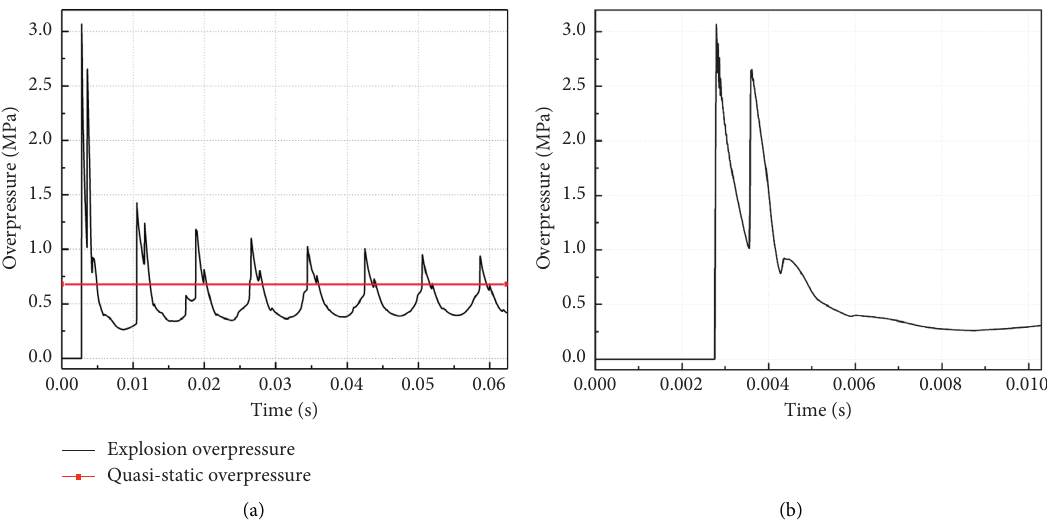
Figure 2: The time history curve of reflected overpressure at gauge 1: (a) explosive load at 0.2 atm and (b) simplified explosive